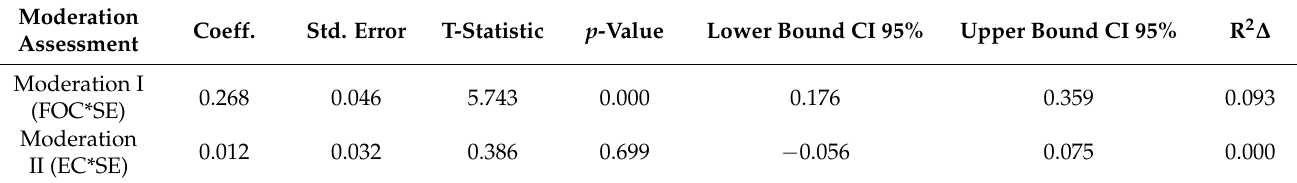
Table 4. Moderation effect.